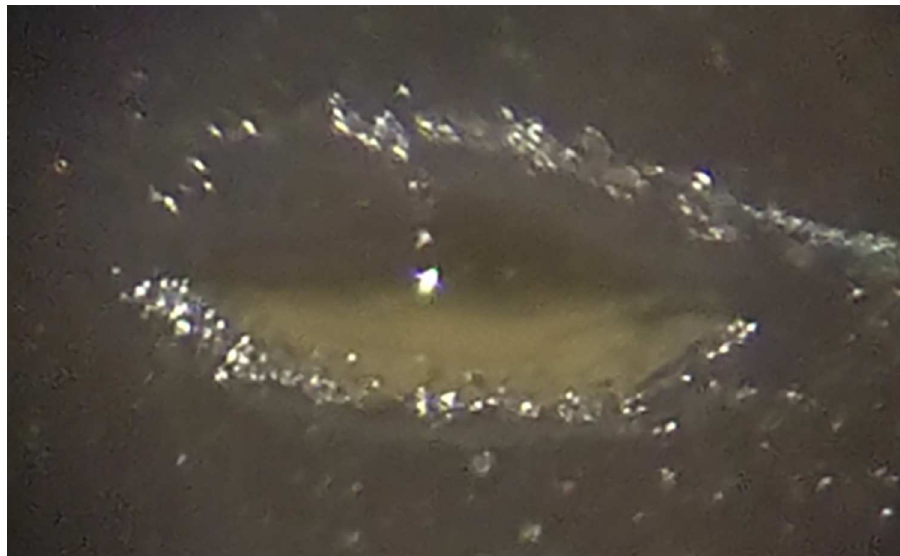
Fig 7. The resultant ablation in corneal